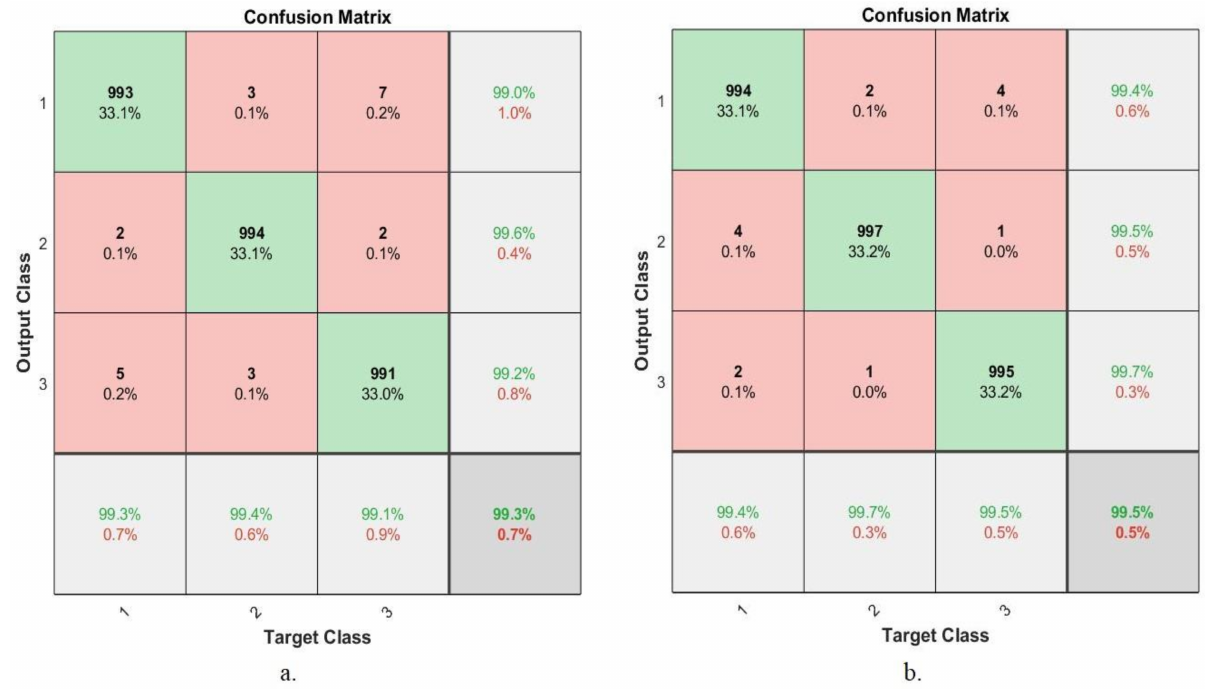
Figure 12. The confusion matrix for the FFNN classifier in the classification of the images of the first dataset based on mixed features: ( a ) DenseNet-121 and hand-crafted; ( b ) ResNet-50 and